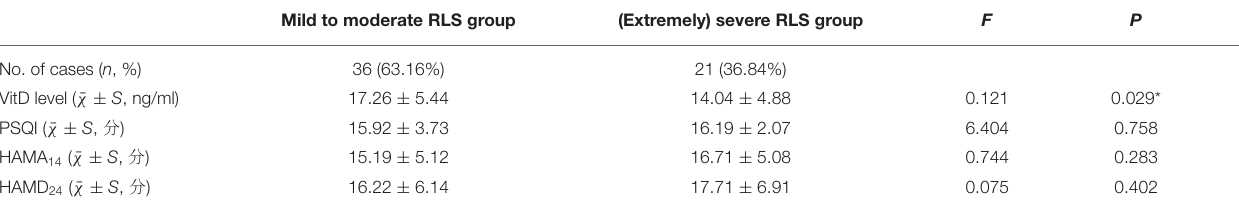
TABLE 2 | Comparison of clinical data between mild to moderate RLS patient group and (extremely) severe RLS patient group. Mild to moderate RLS group (Extremely) severe RLS group F